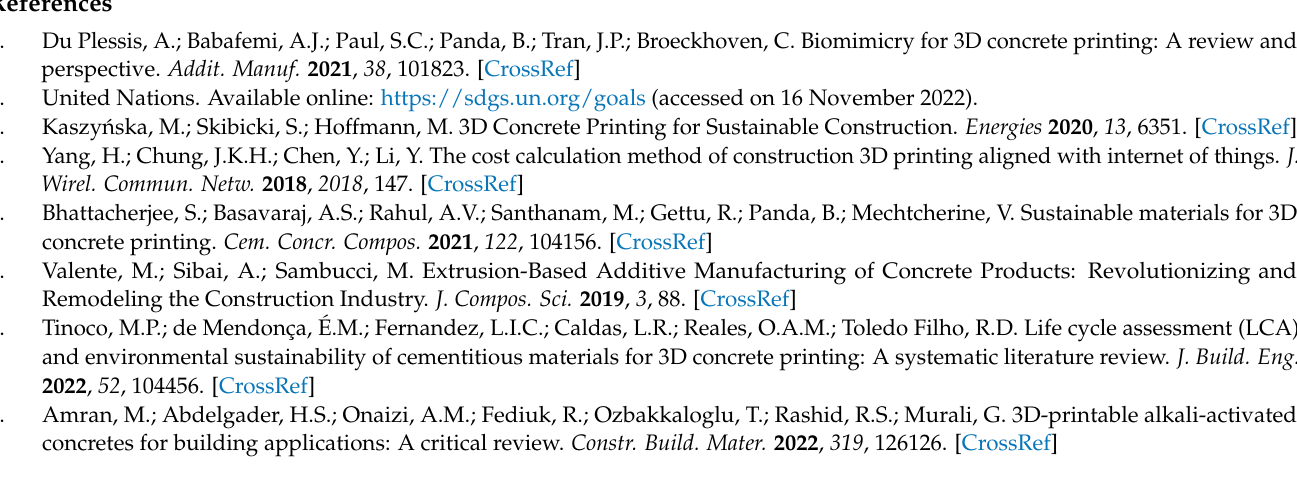
Figure A8. SimaPro CED network for c-RuC mix processing.